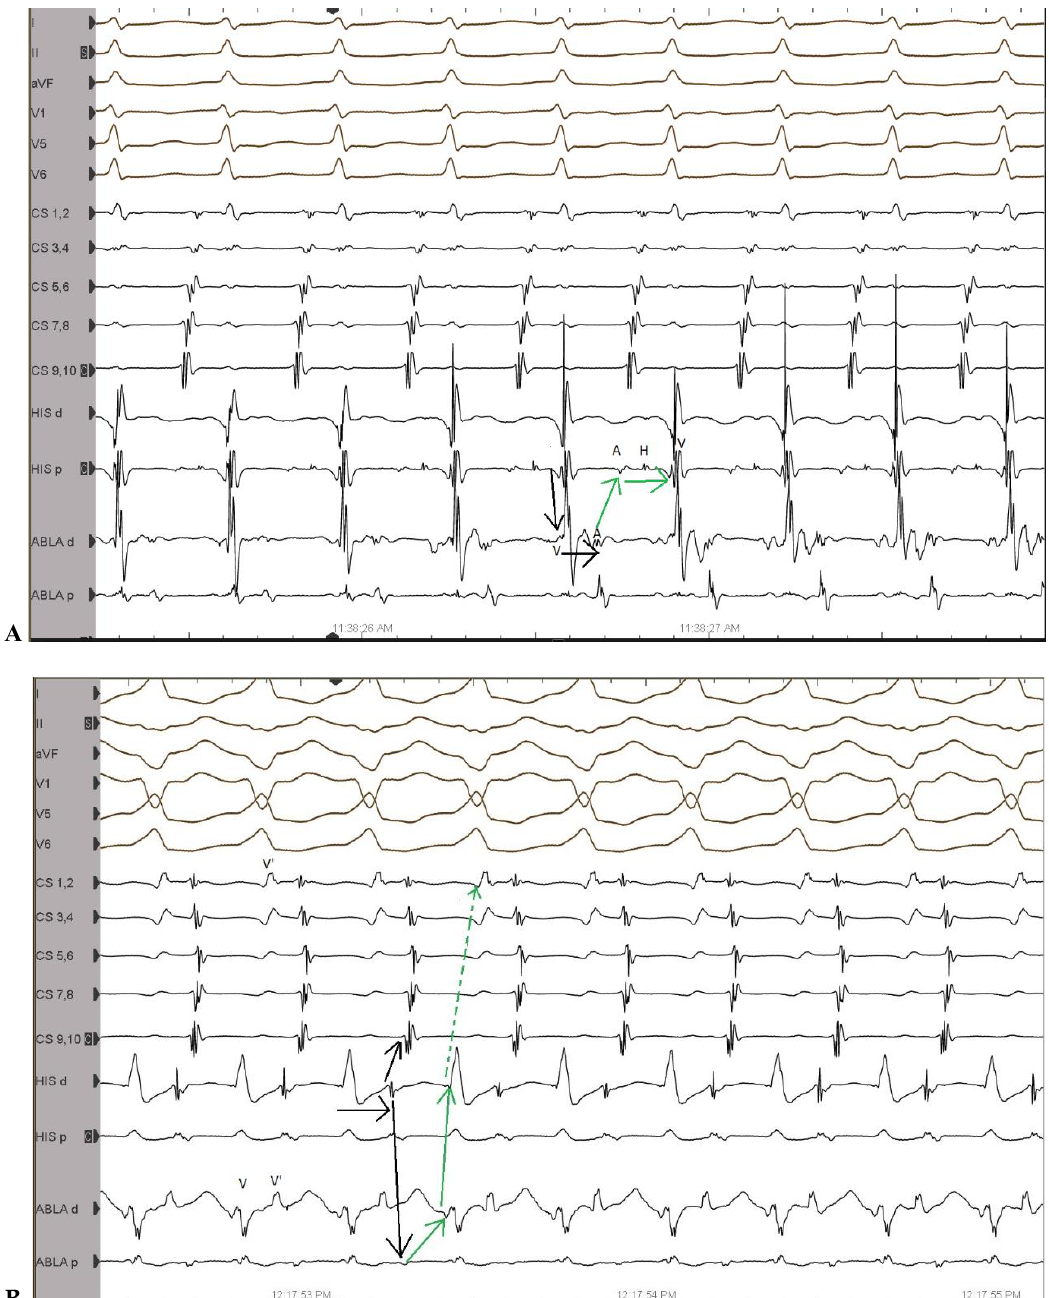
Figure 1. ( A ): Orthodromic AVRT — Shortest VA interval on the ablation catheter without VA fusion; ( B ): antidromic AVRT; ECG leads from the top: DI, DII, aVF, V1, V5, V6. His d and His p indicate distal and proximal His bundle electrogram; CS 1-10, coronary sinus distal to proximal; Abla d and p, ablation catheter distal and proximal, respectively, placed in the RV; A = atrium, H = His, V = v entricle, V’ = far -field ventricle; black and green arrows indicate the sequence of activation.